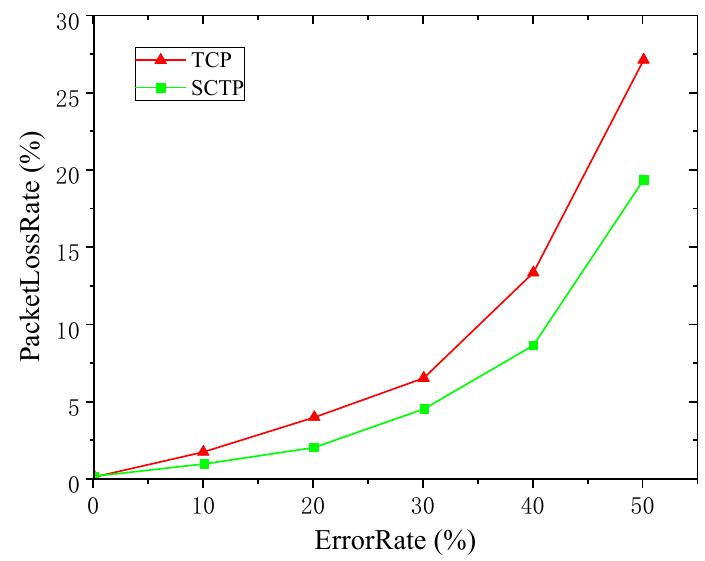
Figure 4. Comparison of the packet loss rate between SCTP and TCP.